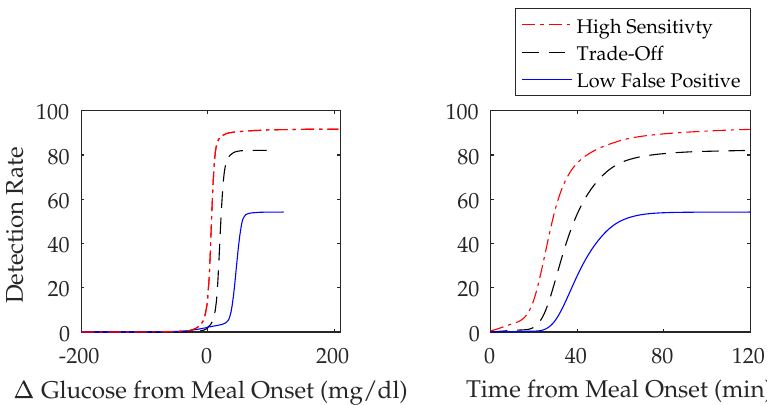
Figure 5. Cumulative detection rates over change in time and ∆ glucose from the onset of meals for the meal algorithm tunings of high sensitivity, trade-off, and low false positive in the sensitivity analysis